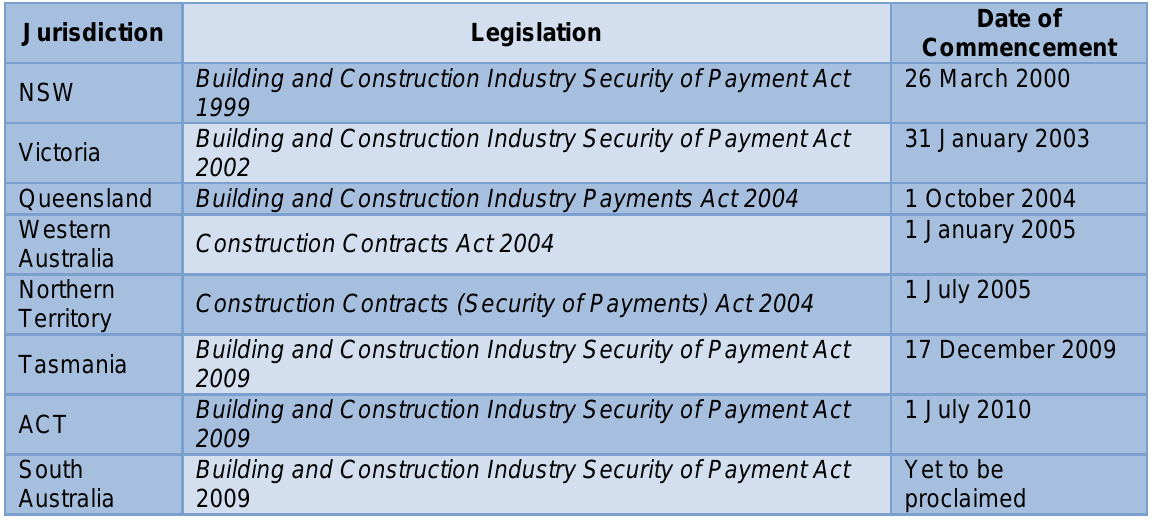
Table 1 Construction industry payment legislation in Australia The key differences between the East and West Coast models have been described by Coggins, Elliott and Bell (2010: 15) as